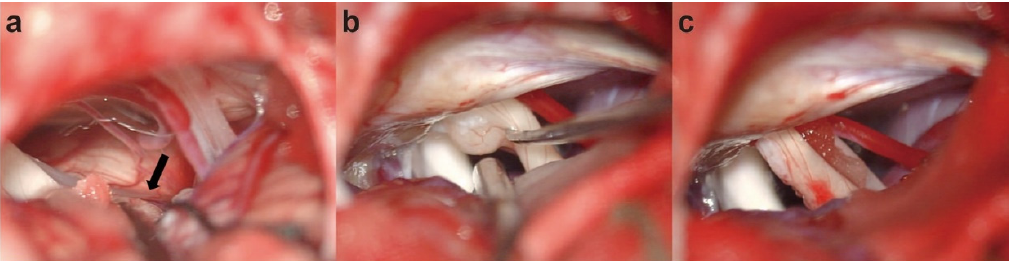
Figure 2. Intraoperative pictures: ( a ) no vascular compression was found in the root exit zone of the facial nerve (black arrowhead); ( b , c ) exploration and complete resection of the vestibular